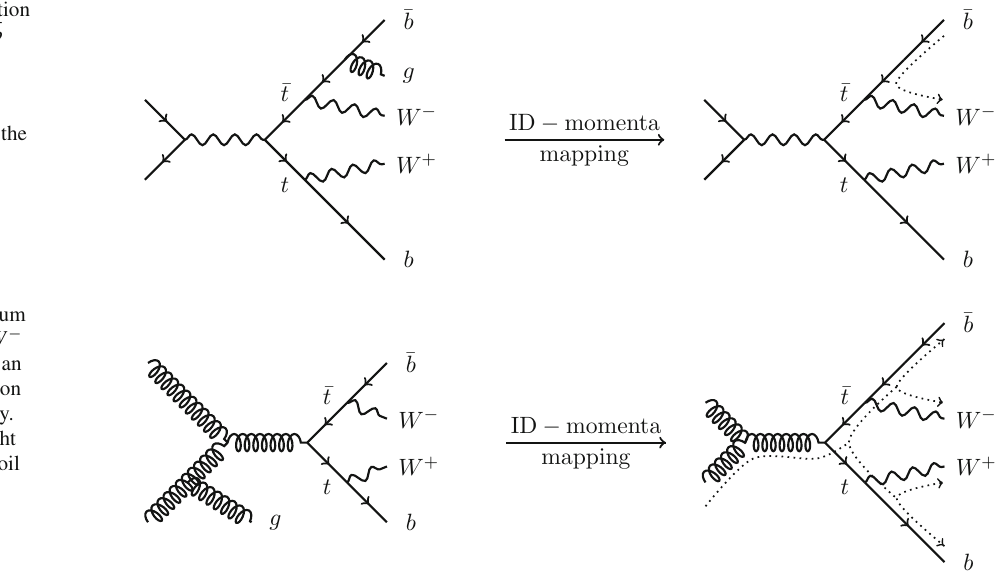
Fig. 6 Exemplary momentum mapping for gg → bW + ¯ bW − from a real configuration to an underlying Born configuration for an initial-state singularity. The curved arrow on the right indicates the flow of the